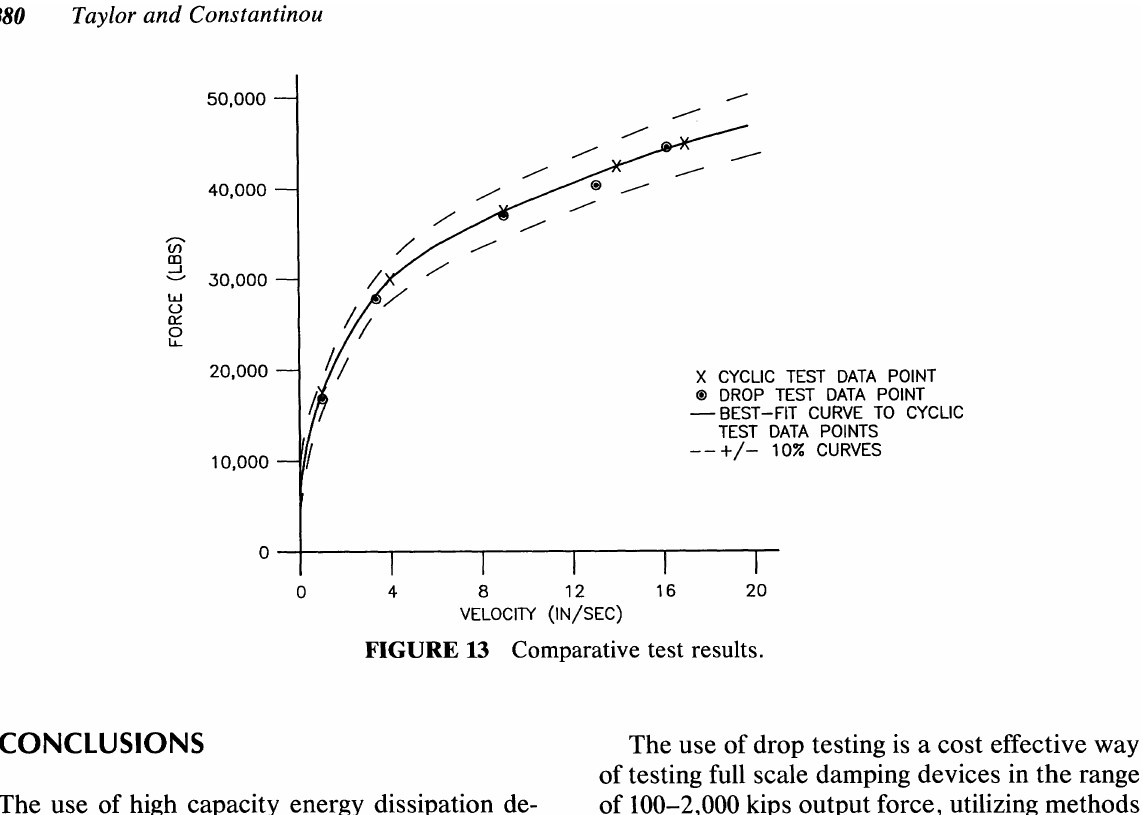
FIGURE 13 Comparative test results.